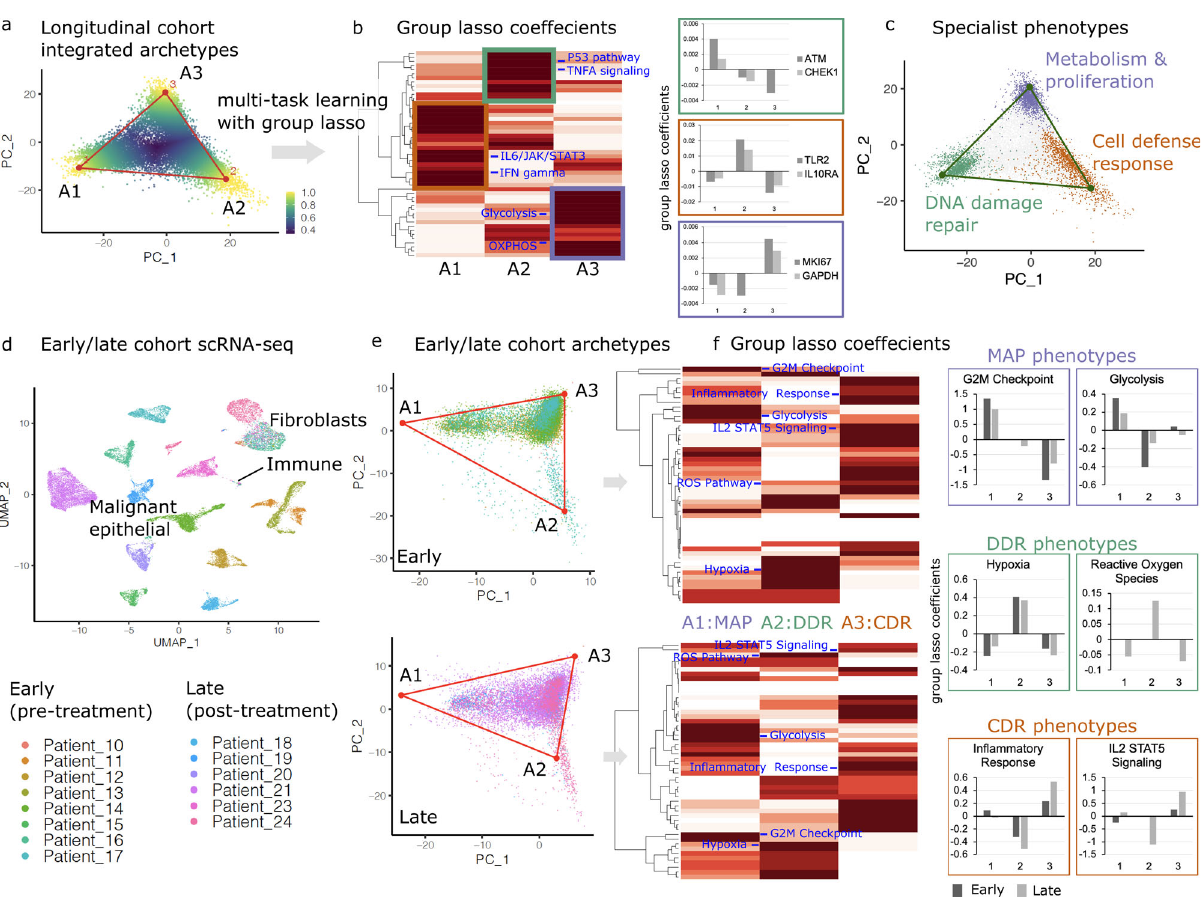
Fig. 2 Archetype analysis to investigate shifts in biological tasks over time. a Cells from the integrated longitudinal cohort are projected on the fi rst two principal components of scRNA-seq data. Each vertex identi fi ed using the Pareto task inference algorithm represents an archetype specializing in a speci fi c biological task. Single cells are colored by maximum archetype score (standardized and inversed Euclidean distance to the vertex), revealing proximity to the nearest archetype. b Heatmap showing the hierarchical clustering of group-lasso coef fi cients for various hallmark pathways associated with each archetype. The three colored boxes display three hierarchical clusters of related phenotypes that reveal the identity of the biological task associated with each archetype. The principal pathways that de fi ne the archetypes are indicated on the heatmap in blue, with the green box indicating DNA-damage repair (DDR), the red box indicating cellular defense response (CDR), and the blue box indicating metabolism and proliferation (MAP) archetypes. The inset bar plots show the group-lasso coef fi cient ( Y -axis) of key genes corresponding to the three archetypes ( X -axis) from the scRNA-seq data of the longitudinal cohort patients. Source data for single gene coef fi cients are provided as Source Data fi le. c Three major biologicals tasks were predicted using the multitask learning approach. Specialist cells are colored according to the closest archetype (cells in the 95th percentile), whereas non-specialists distal from all three archetypes are shown in gray. d Dimensionality reduction (UMAP) projections and clustering of the integrated 28K high-quality cells, including 21K malignant epithelial cells, from the early/late (pre-/post-treatment) cohort pro fi led using 10× platforms. Patients 10 – 17 were treatment-naive, while patients 18 – 24 received multiple lines of treatment. Major predicted cell types are annotated to show separate clusters with malignant epithelial cells, immune cells, and fi broblasts. e Archetypes are annotated on the principal component projections of the early and late cohorts. The samples from each cohort are shown separately to clearly display the population shifts in the archetypes. f Hierarchical clustering of group-lasso coef fi cients for archetypes determined for early and late cohort patients, with principal pathways de fi ning the archetypes indicated in blue. The inset bar plots on the right show group-lasso coef fi cients ( Y -axis) of key pathways that were used to de fi ne the phenotypes associated with each of the three archetypes ( X